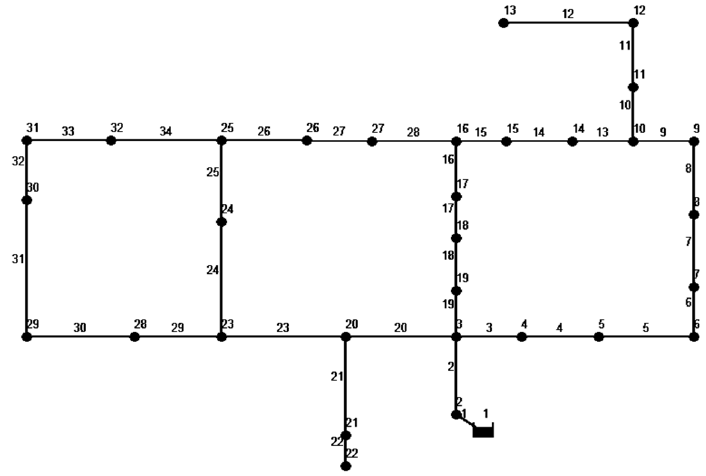
Figure 3. Layout of the Hanoi network.